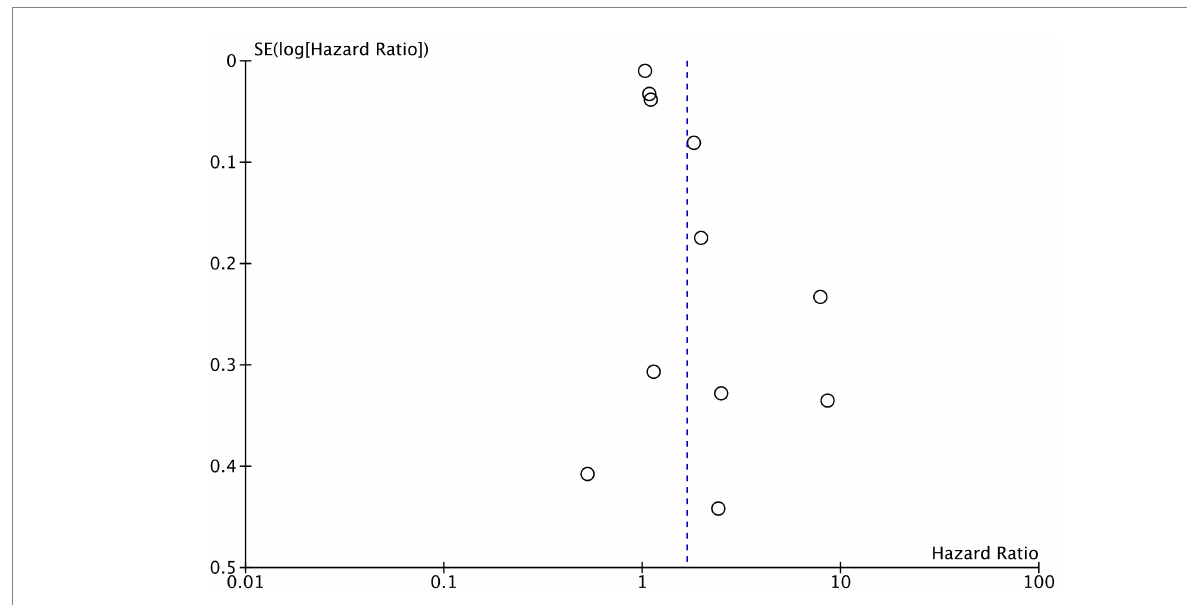
FIGURE 3 Funnel plot for the meta-analysis of mortality with PNI as a categorical